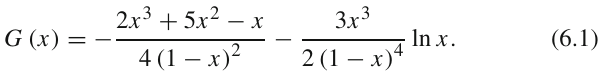
process pp → N N → e ± μ ∓ 4 j as well as for the ster- ile neutrino decays, to the ones obtained in Ref. [230]. A slightly different prediction is expected for the N → l decay rate, which in our model receives contributions from the diagrams involving the off-shell W and W (cid:2) gauge bosons, whereas in the model of Ref. [230], it only receives contri- bution from the diagram involving the off-shell W gauge boson. It is worth mentioning that the contribution to the ν l − N → l + k decay rate arising from the the exchange of i j the off-shell W (cid:2) gauge bosons is strongly suppressed by a M 4 W factor of about M